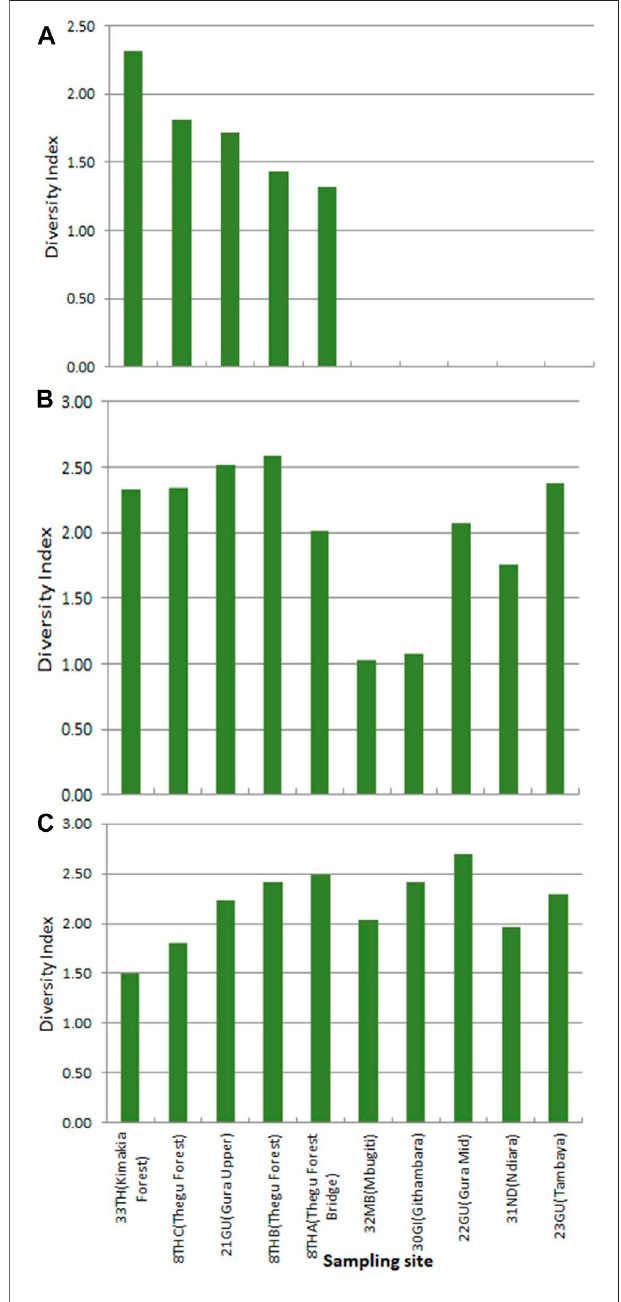
FIGURE 11 | Bird species diversity of (A) forest specialists, (B) forest generalists, and (C) forest visitors at each sampling site.